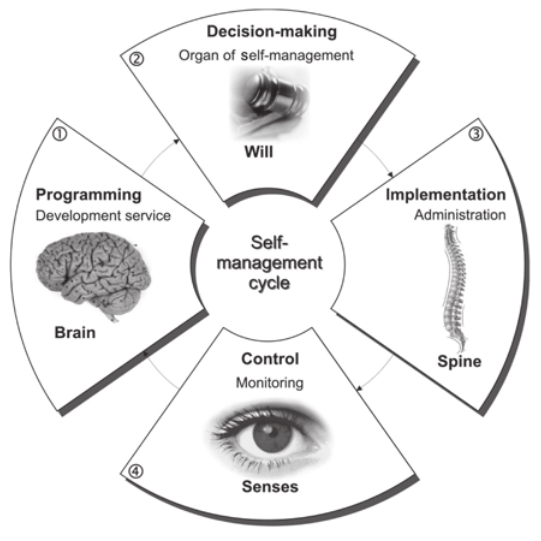
Fig. 3. Self-management cycle of a live